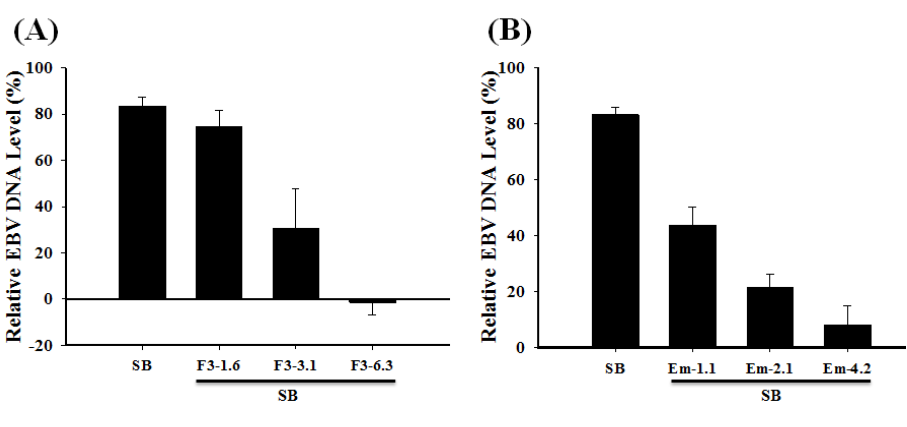
Figure 7. Effects of F3 and emodin on EBV DNA replication. F3 (1.6, 3.1 and 6.3 μ g/mL) or emodin (Em) (1.1, 2.1 and 4.2 μ g/mL) was added to P3HR1 cells before SB induction for 48 h. The expression of EBV DNA was studied by real-time PCR